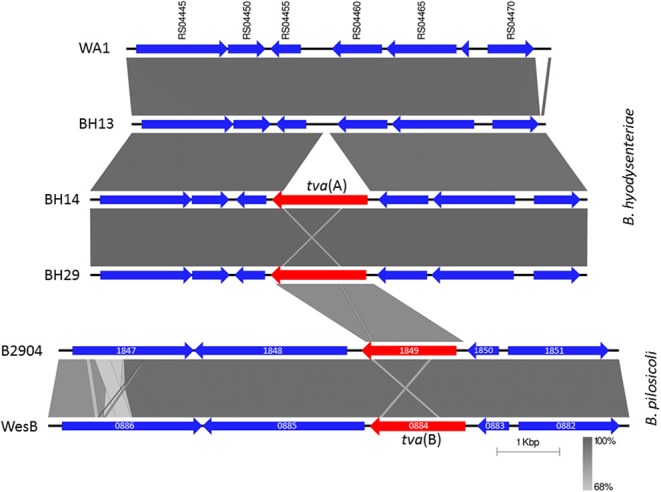
Chromosomal arrangement of genes in Brachyspira hyodysenteriae and Brachyspira pilosicoli surrounding tva(A) and tva(B) respectively. B. hyodysenteriae genes labelled according to the locus tag in the reference strain WA1 (Accession number NC_012225); tva(A) is not present in WA1 and therefore has no locus tag. Genes have been coloured to indicate tva(A) and tva(B) in red and other genes in blue. WA1 and BH13 were tiamulin susceptible (MIC ≤ 0.063 mg/L). Field isolates BH14 and BH29 were recovered from different holdings, harboured tva(A) and had intermediate tiamulin MICs (0.5 mg/L). Also shown is the region surrounding tva(B) from B. pilosicoli isolates B2904 (Accession number CP003490; locus tag B2904_orf1849) and WesB (Accession number HE793032; locus tag WESB_0884); other genes labelled according to their locus tags. Regions of homology between isolates are shown by grey shading. Image generated using EasyFig (Sullivan et al., 2011).